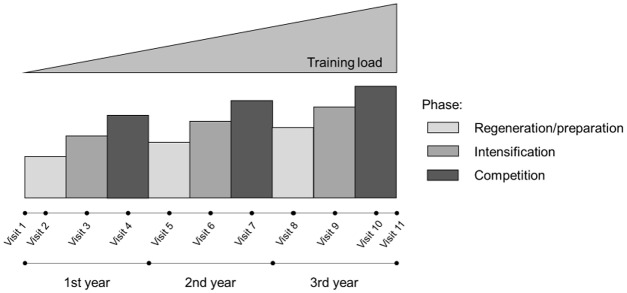
Timeline for the prospective study.